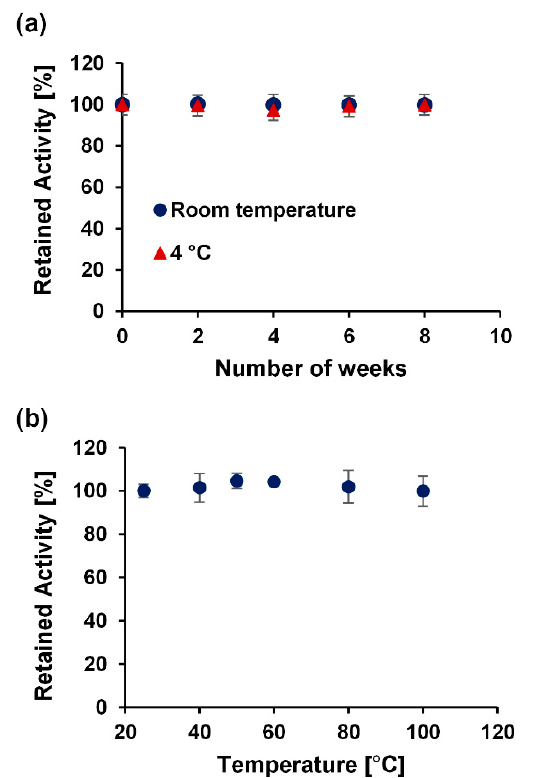
Figure 9. Stability test on µPAD at varying time intervals and conditions. Retained activity of the test kit ( a ) over a period of 2 months (8 weeks) at room temperature and at 4 °C and ( b ) after 20 min at varying temperatures from 25 °C to 100 °C. Each data point is the mean of the three individual experiments ± standard deviation.